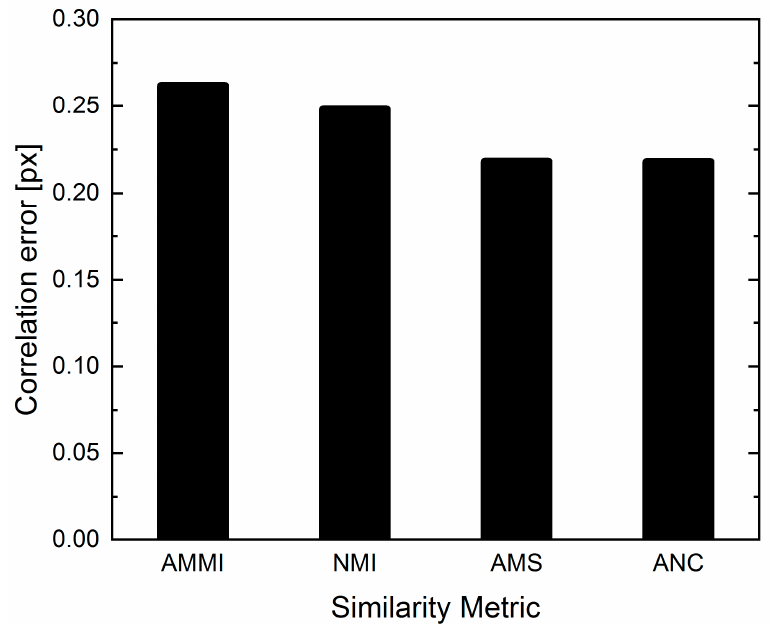
Figure A2. Correlation errors after DVC run with different similarity metrics.